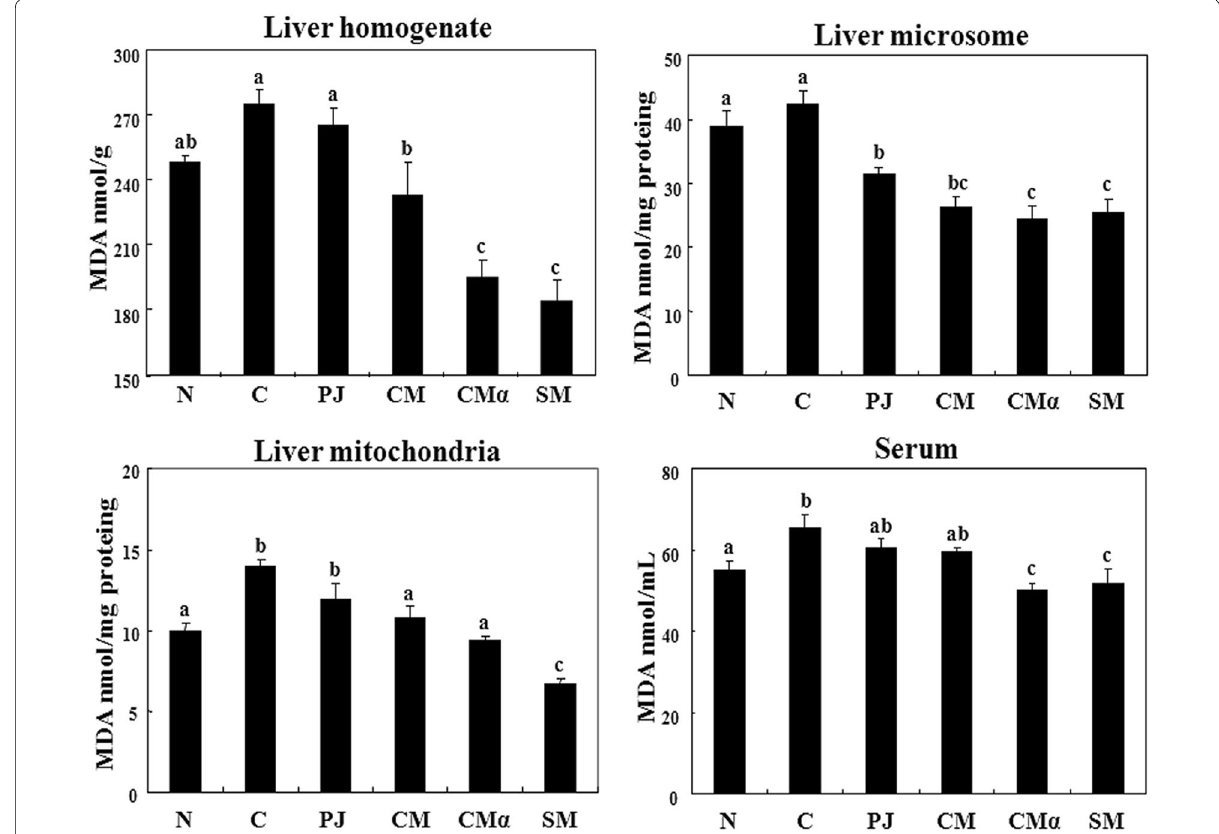
Fig. 2 Hepatic and serum levels of thiobarbituric acid‑reactive substances